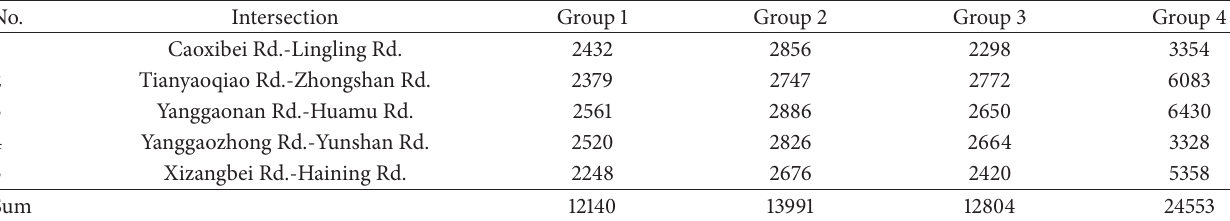
Table 2: Number of measured vehicles for the surveyed intersections.